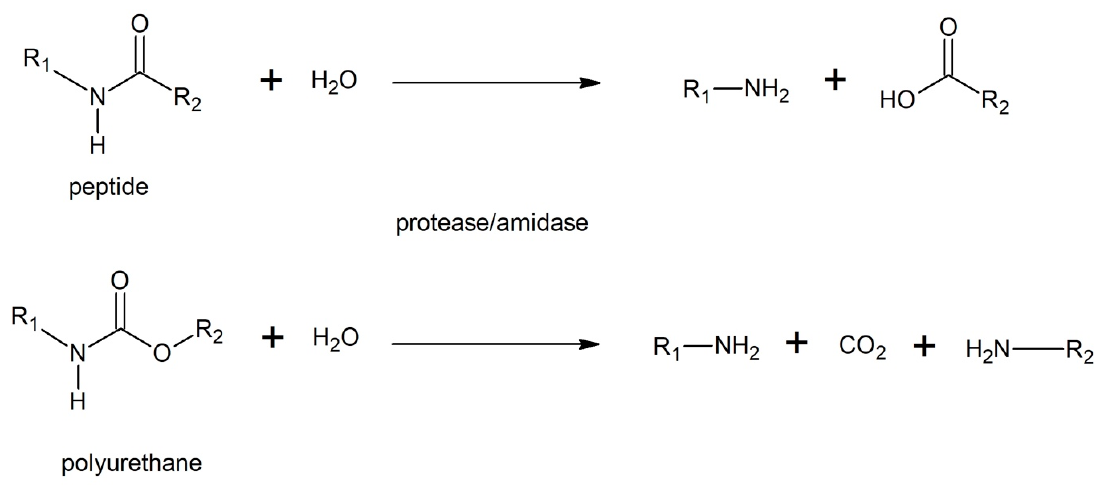
Figure 9. Hydrolysis of polyurethane and peptide by protease/amidase.